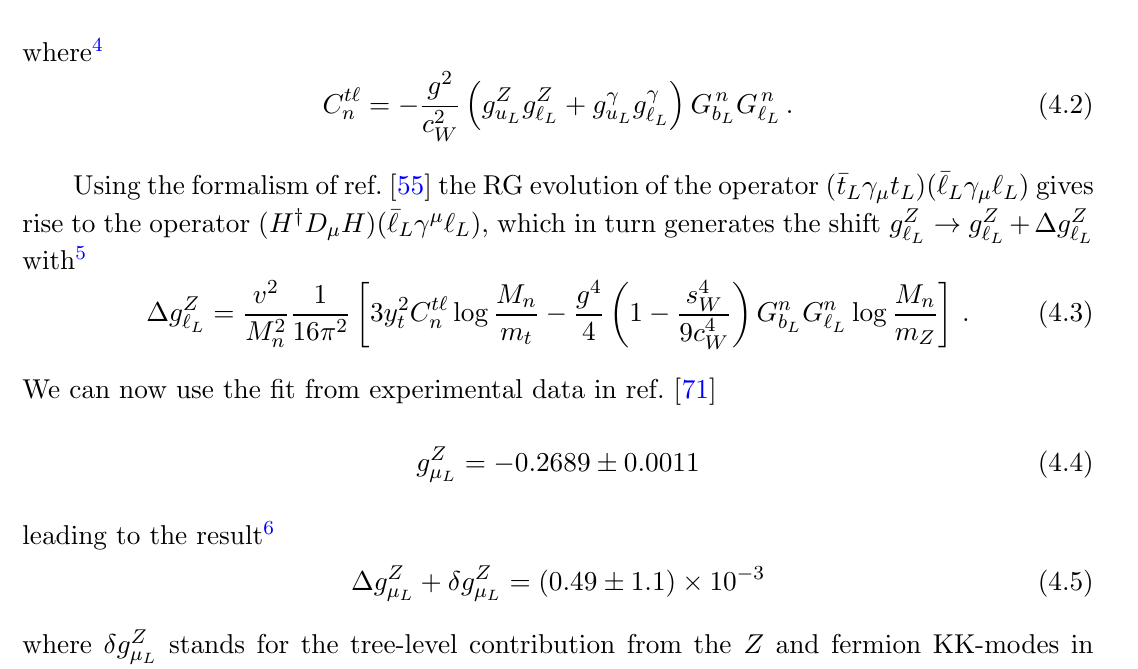
+ (cid:14)g Z as shown in eq. (4.5). (cid:22) L (cid:22) L